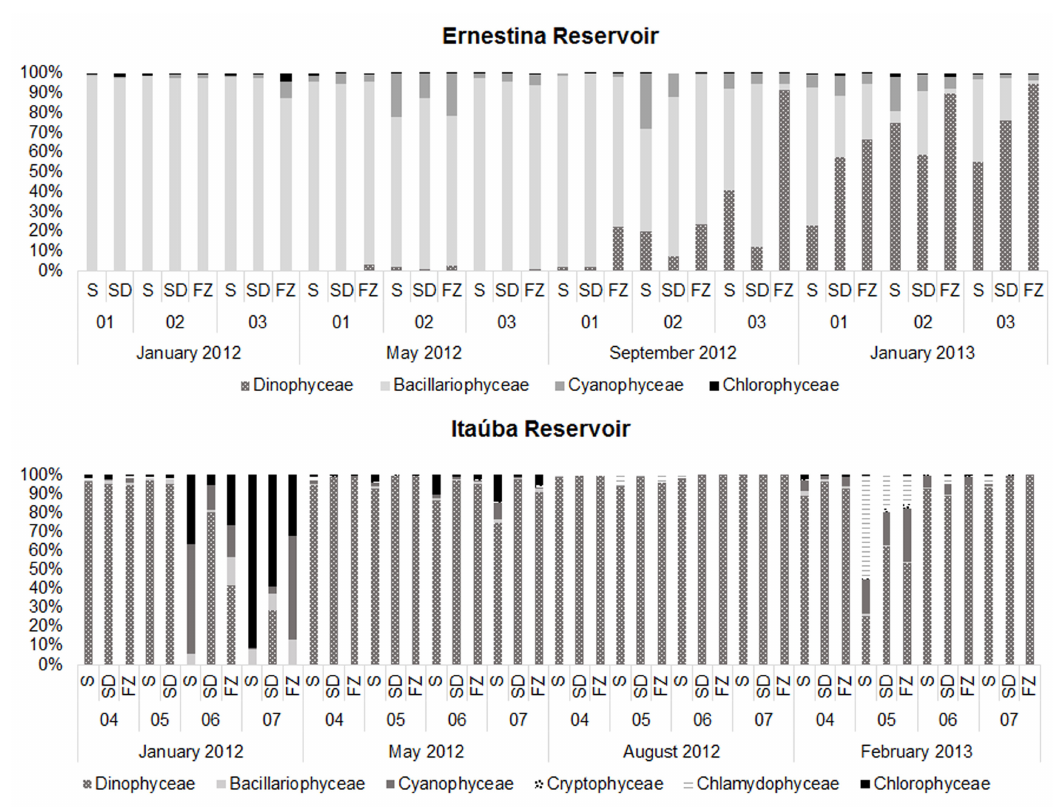
Figure 7. Percentage biovolume (µm 3 .ml -1 ) of phytoplankton taxonomical classes in Ernestina and Itaúba reservoirs between January 2012 and February